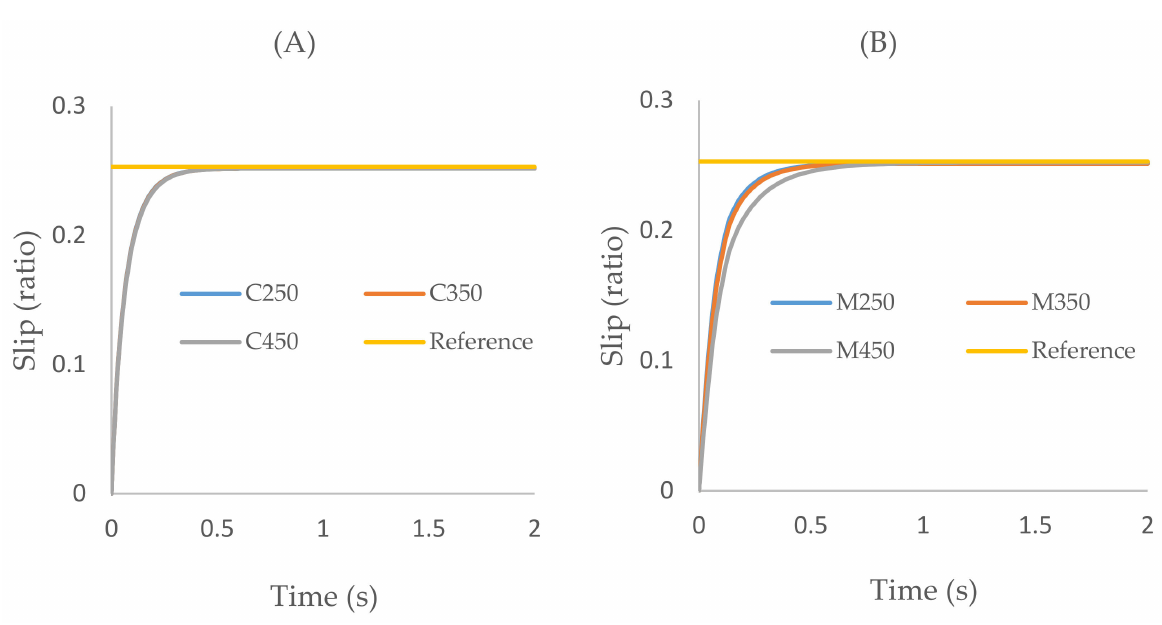
Figure 6. Estimation of optimum friction coefficient.